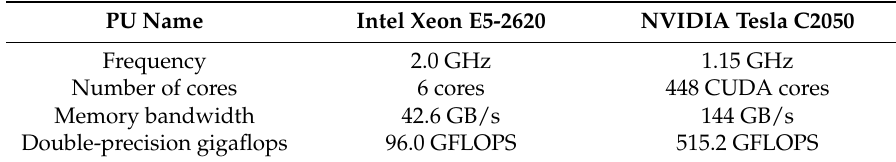
Table 1. Detailed information of experimental Processing Units (Pus) on